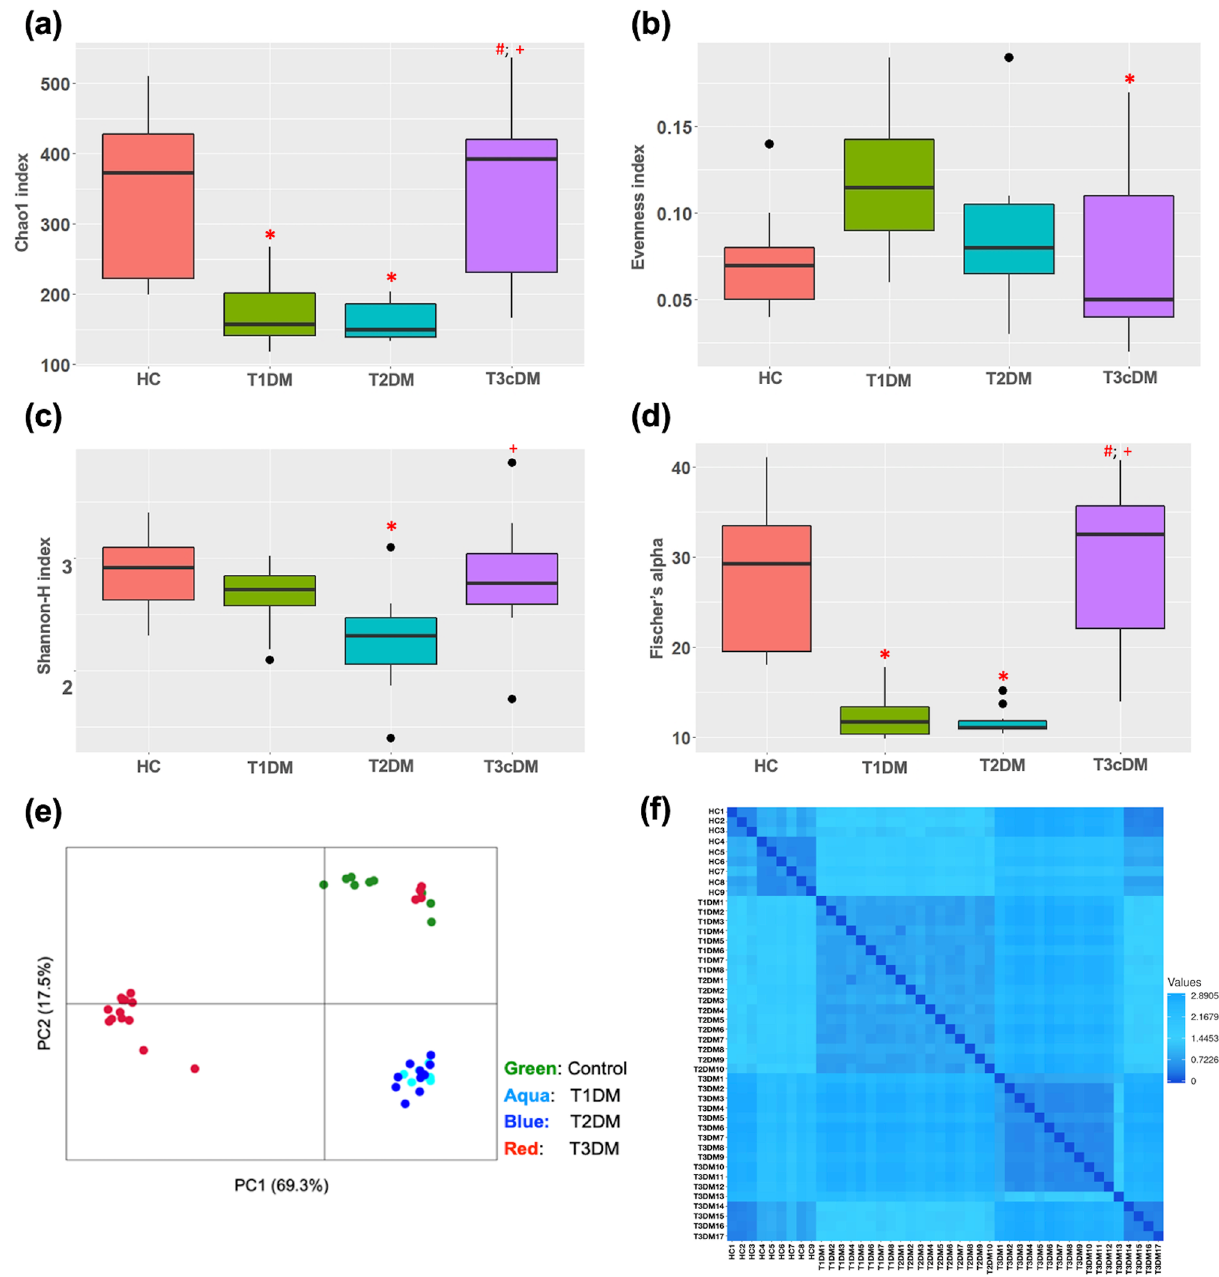
Figure 2. Fecal microbial diversity among the study patients. Box and whisker plots in panels a-d represent the alpha diversity indices. ( a ) Chao I, ( b ) Evenness index, ( c ) Shannon index, ( d ) Fischer’s alpha. Panels ( e ) Principal coordinate analyses [PCoA] plot using Euclidean distance and ( f ) Heatmap representing the intergroup and intragroup beta diversity, based on Euclidean distance, among the study groups. The p values were derived using the Kruskal–Wallis test with Tukey’s post-hoc pairwise analyses. * indicates statistically significant difference compared to healthy control; # compared to Type 1 diabetes and + compared to Type 2 diabetes. Refer to Supplementary Table 3 for exact p